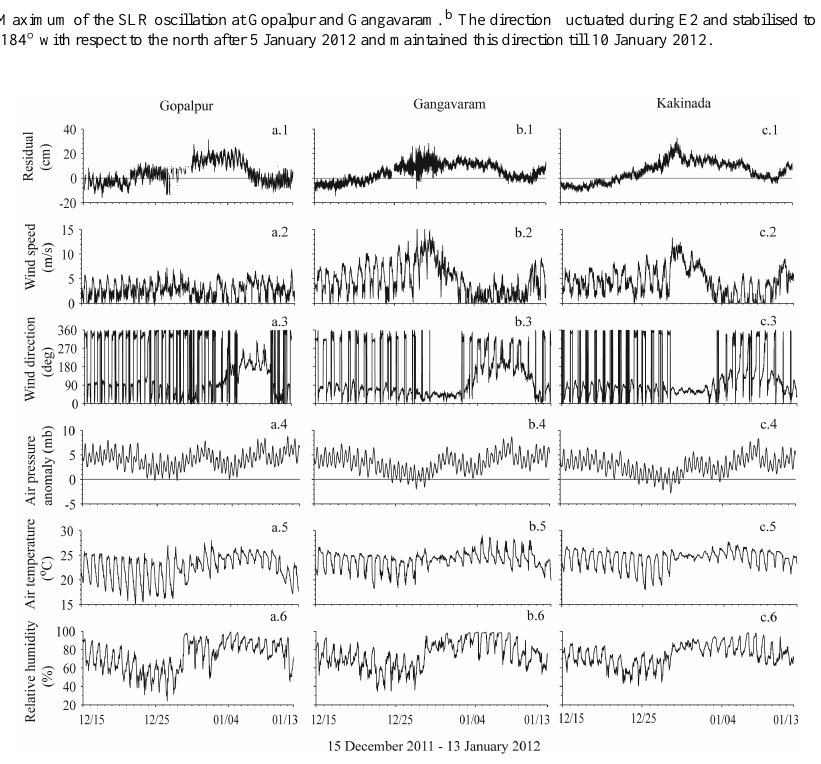
Figure 5. Sea level residual and surface meteorological parameters during the episodic event E2. (a.1 to a.6) SLR, wind speed, wind direction, atmospheric pressure anomaly, air temperature and relative humidity at Gopalpur, Odisha. (b.1 to b.6) same as in (a) at Gangavaram, Andhra Pradesh. (c.1 to c.6) same as in (a) at Kakinada, Andhra Pradesh. The atmospheric pressure anomaly is estimated by subtracting the